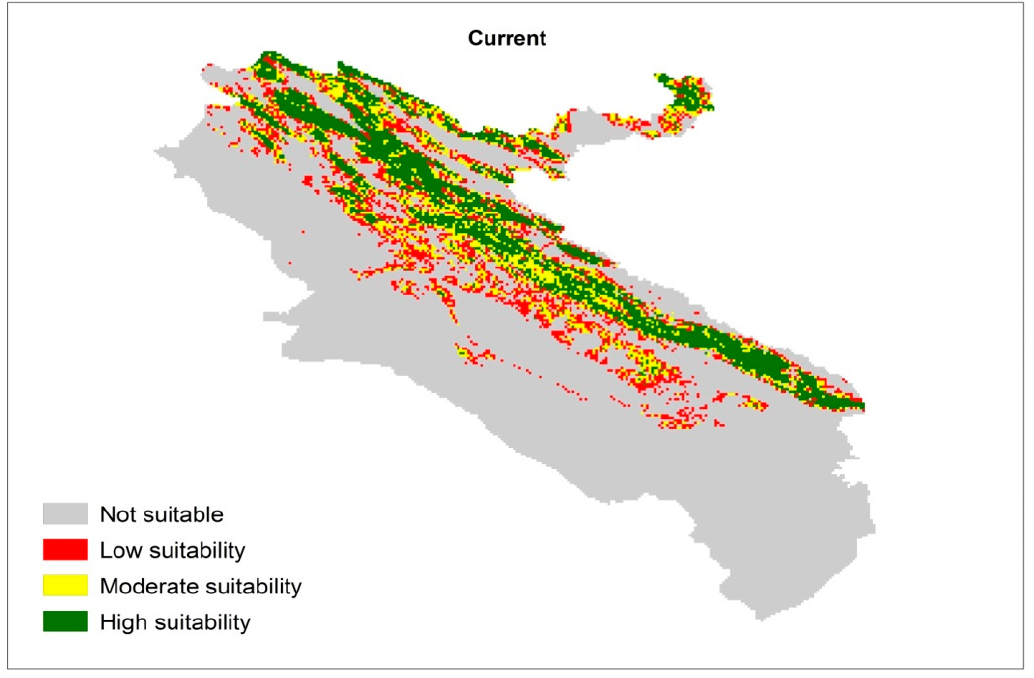
Figure 6. Habitat suitability map for Persian oak ( Quercus brantii ) in the west of Iran based on the BART model under current climatic conditions.